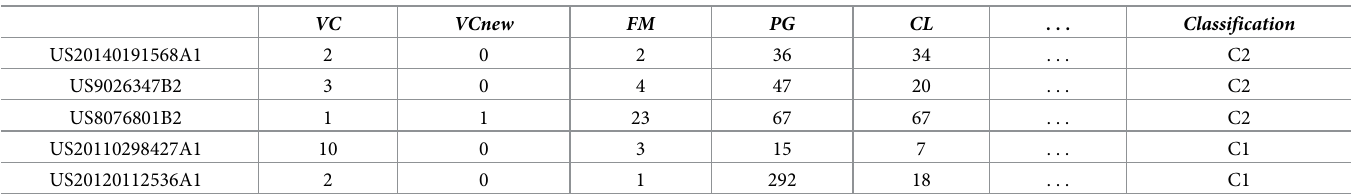
Table 4. An example of the highly cited patent identification indicator system.